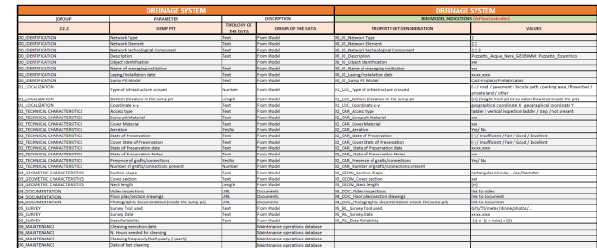
Figure 2. List of the information requirements (e.g. Sump Pit of the Sewer